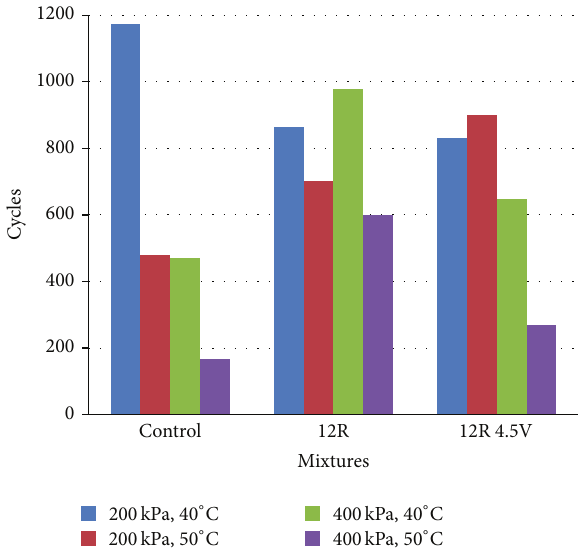
Figure 7: Number of load cycles at first stage for control and rubberized mixtures at all test